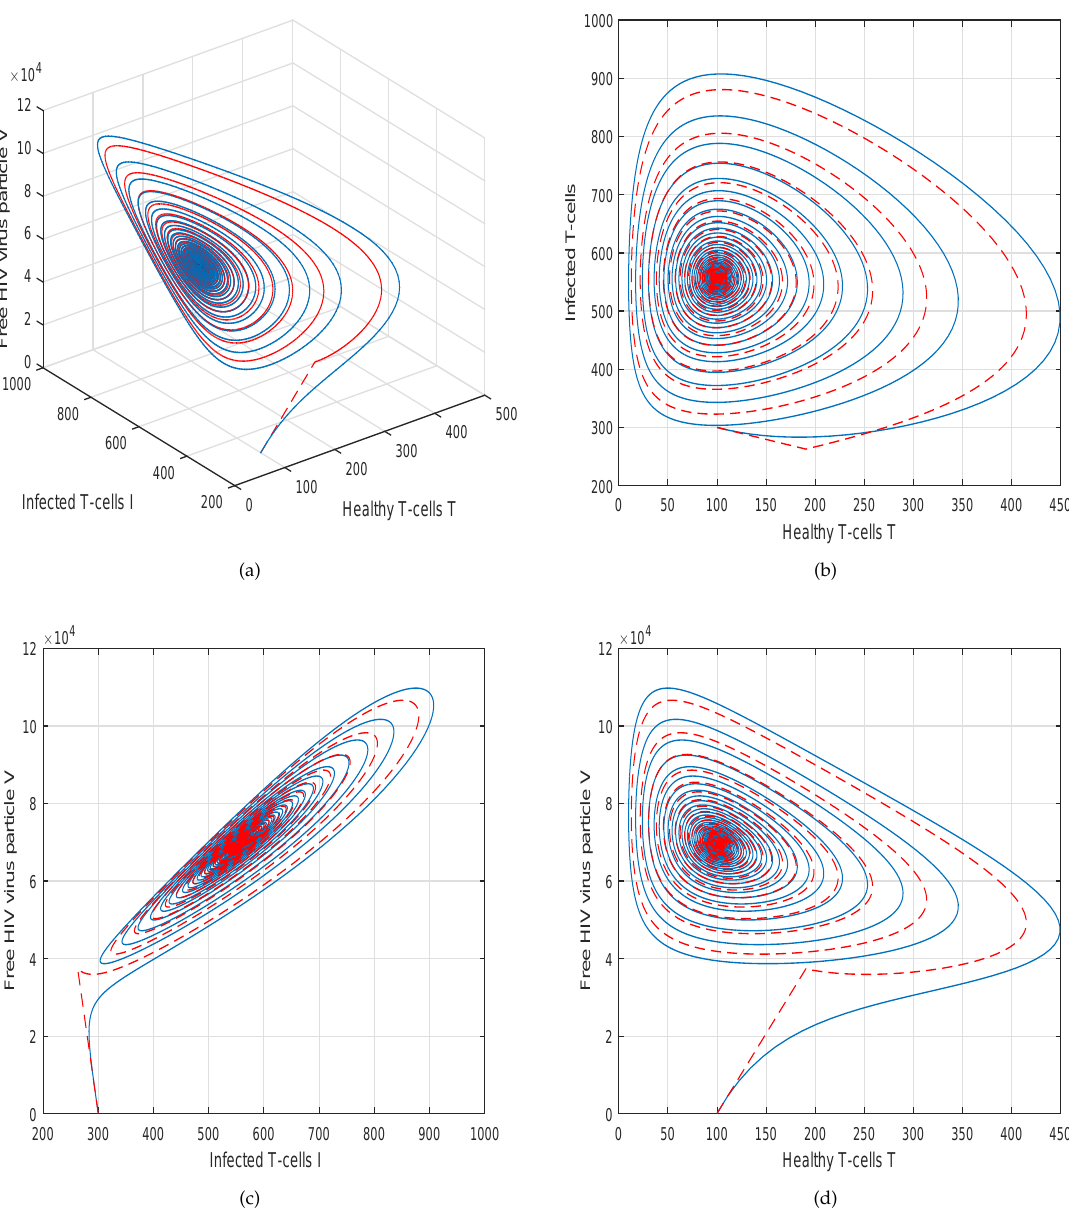
Figure 7. Illustration of the ( a ) chaotic behavior, ( b ) phase portrait of healthy CD4 + T-cells verses infected CD4 + T-cells, ( c ) phase portrait of infected CD4 + T-cells verses free HIV virus particles and ( d ) phase portrait of healthy CD4 + T-cells verses free HIV virus particles of the fractional model (2) of HIV infection with fractional-order ϑ =